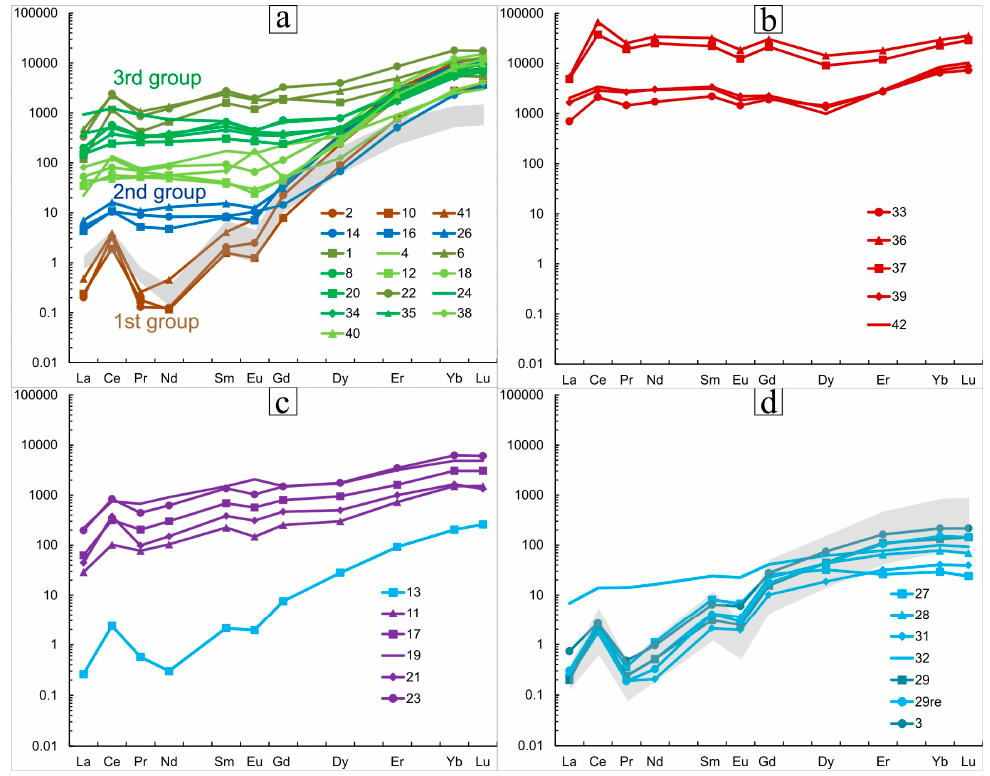
Figure 7. Zircon REE distribution patterns normalized to CI chondrite [ 35 ]. ( a ) dark-CL pegmatite zircons (main population). The characterization of zircon groups is given in the text. The grey field shows the composition of zircons from the pegmatites cutting Salma eclogites [ 18 , 20 ]; ( b ) dark grey in BSE imaging alteration zones in zircons; ( c ) inherited zircon cores; ( d ) zircons with sectorial (mosaic) CL zoning. The grey field shows the composition of zircon cores from the eclogite boudin cut by the pegmatite vein